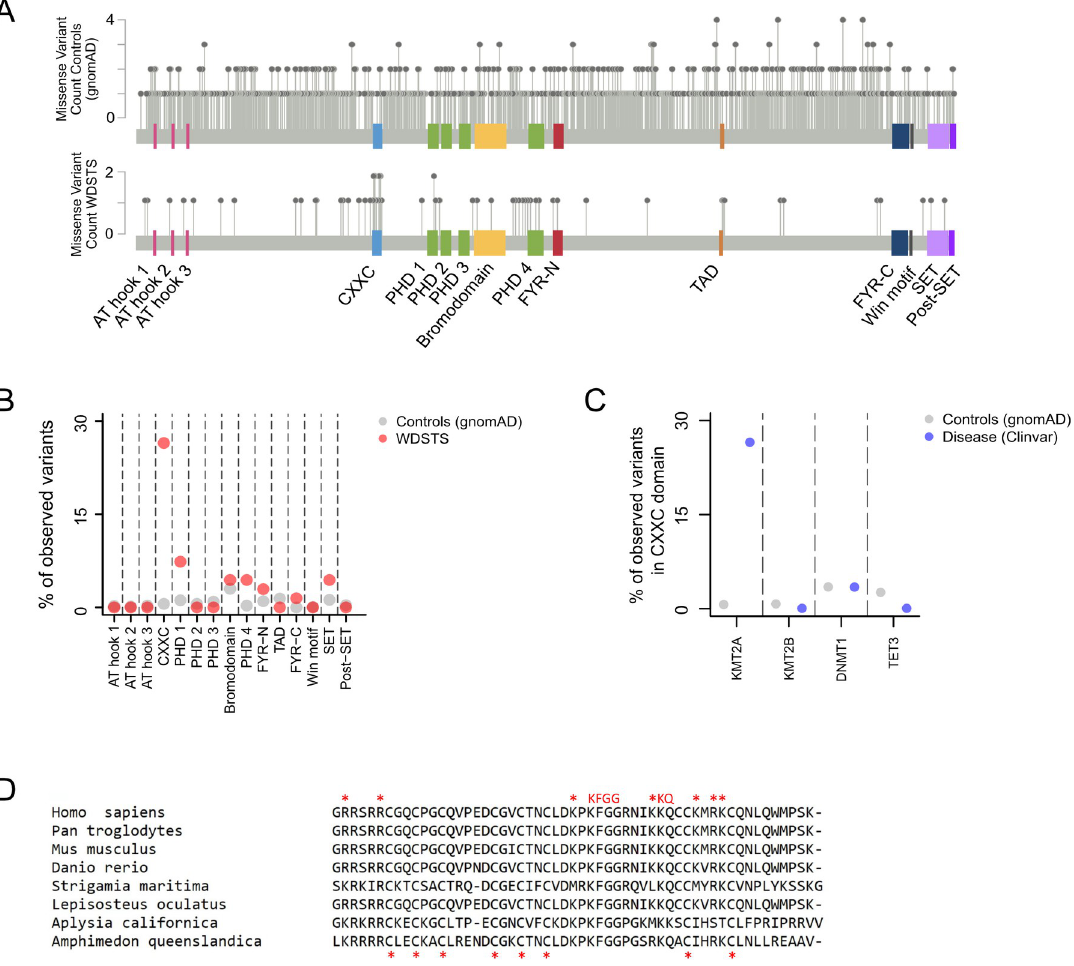
Fig 1. The distribution of likely pathogenic Wiedemann-Steiner syndrome missense variants across the different domains of KMT2A . (A) KMT2A missense variants in gnomAD (top) and WDSTS (bottom). See Methods for filtering criteria. (B) The percentage of missense variants from gnomAD (grey dots) and WDSTS (red dots) that fall in each of the different domains of KMT2A. (C) The percentage of missense variants in gnomAD (grey dots) and likely pathogenic variants (blue dots) that fall in the CXXC domain of different epigenetic regulators. (D) Multiple sequence alignment of the amino-acid sequence of the CXXC domain of KMT2A in eight eukaryotic species. Residues known to be important for DNA binding are marked with red asterisks at the top (see Methods for details). The eight zinc ion-binding cysteines are marked with red asterisks at the bottom.